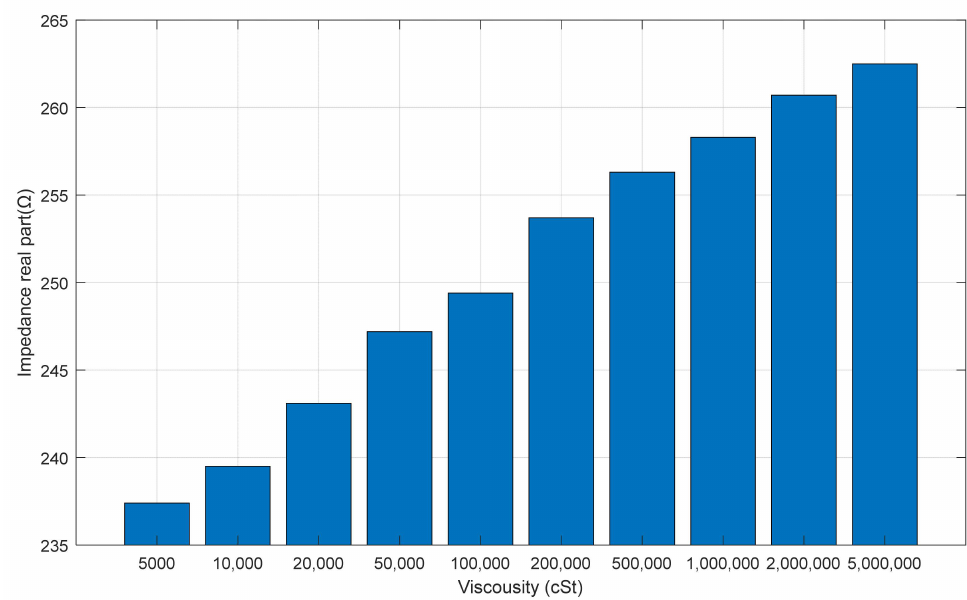
Figure 12. Impedance frequency peaks at different viscosity damping